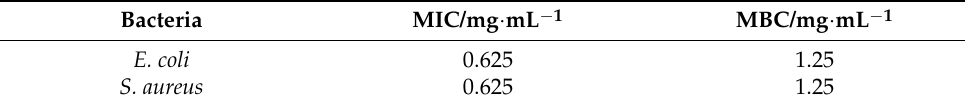
Table 1. The MIC and MBC of CSNPs against E. coli and S. aureus